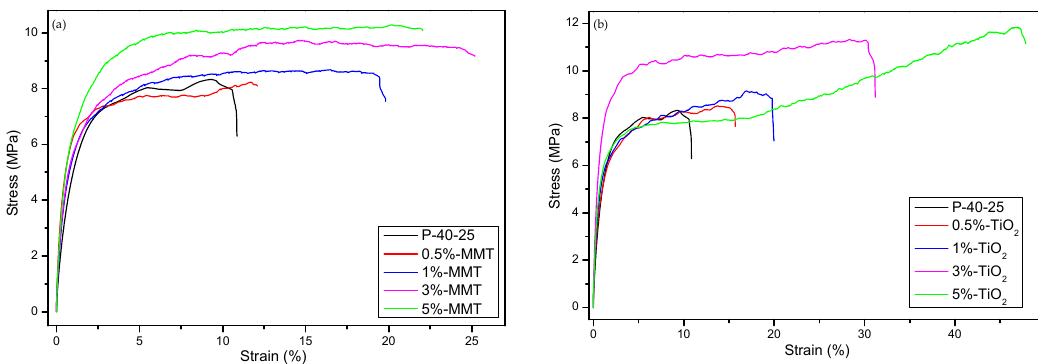
Figure 6. Tensile properties of ( a ) P‐40‐25 incorporated with MMT and ( b ) P‐40‐25 incorporated with TiO 2 . Nanomaterials 2019 , 8 , x FOR PEER REVIEW